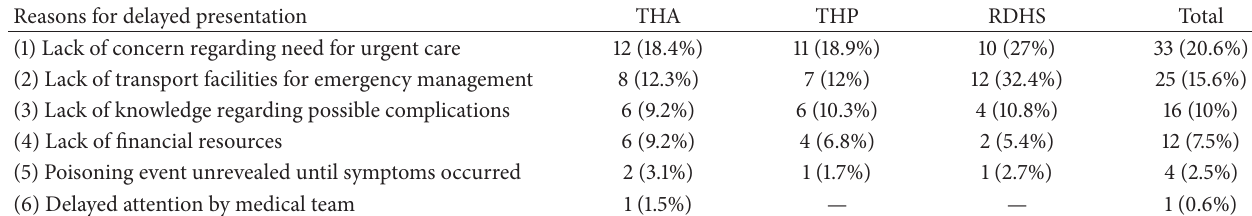
Table 4: Reasons for delayed presentation to primary care unit among children in rural Sri Lanka. Reasons for delayed presentation